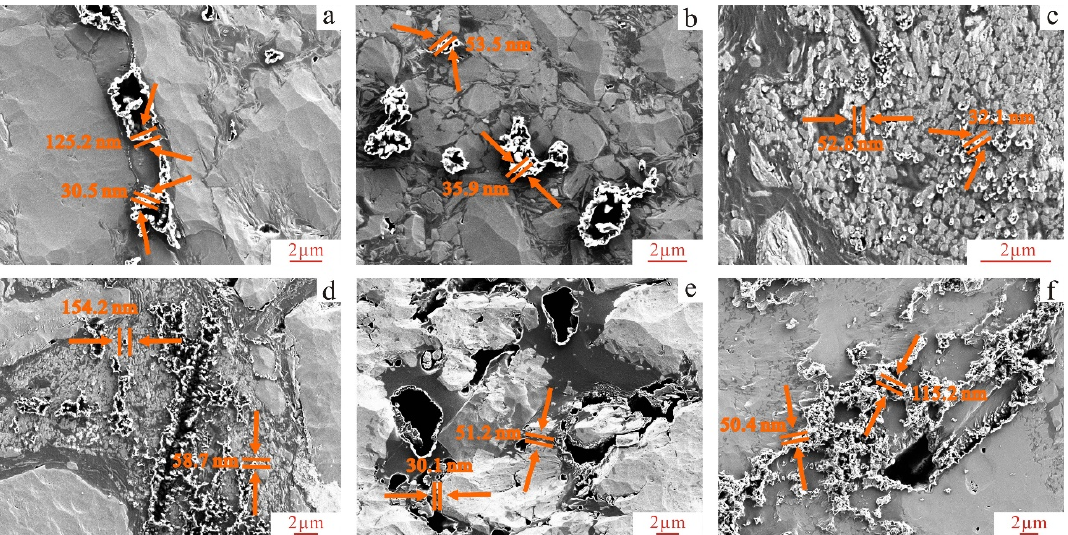
Figure 12. Characteristics of movable oil in the Ek 2 shales in the Cangdong Sag. ( a ) Well G-C, 4106.79 m, laminated felsic shale. ( b ) Well G-C, 4112.41 m, laminated mixed shale. ( c ) Well G-A, 3212.21 m, laminated felsic shale. ( d ) Well G-A, 3189.36 m, La. ( e ) Well G-D, 3896.92 m, laminated felsic shale. ( f ) Well G-D, 3821.67 m, laminated carbonate shale.